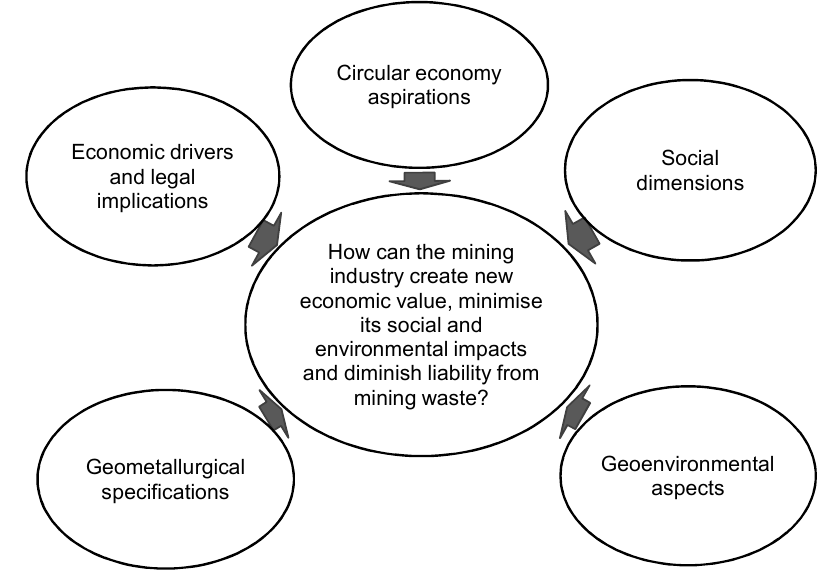
Figure 1. Key areas of an integrative approach for mining waste.